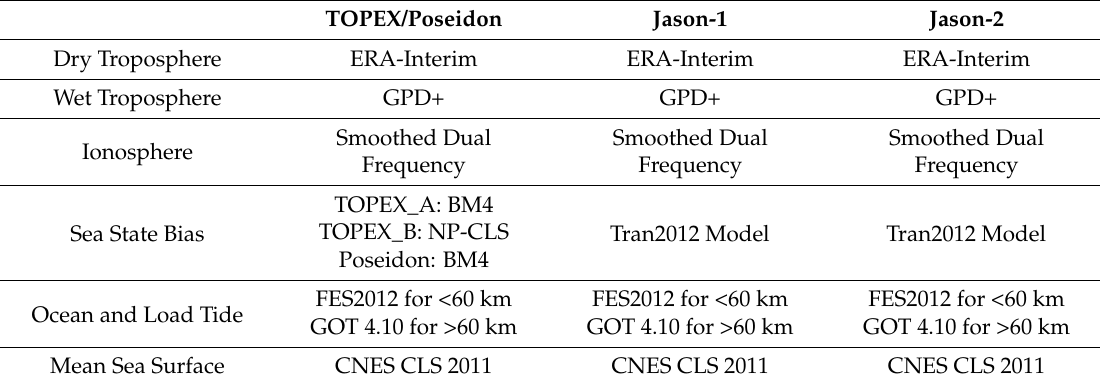
Table 3. Selected range and geophysical corrections and mean sea surface model.